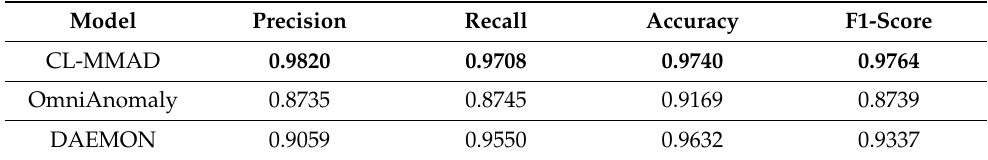
Table 7. Comparisons with baseline